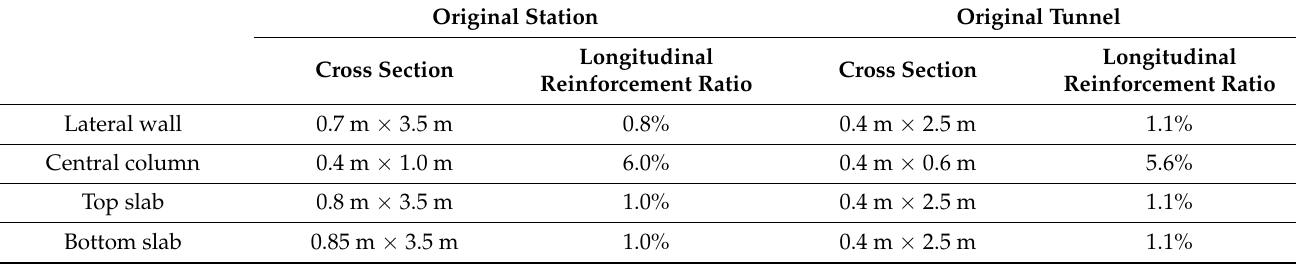
Figure 3. Section reinforcement of columns in original structures and the new station (unit: mm): ( a ) Reinforcement of columns in the original station; ( b ) Reinforcement of columns in the original tun- nel; ( c ) Reinforcement of columns in the new station.